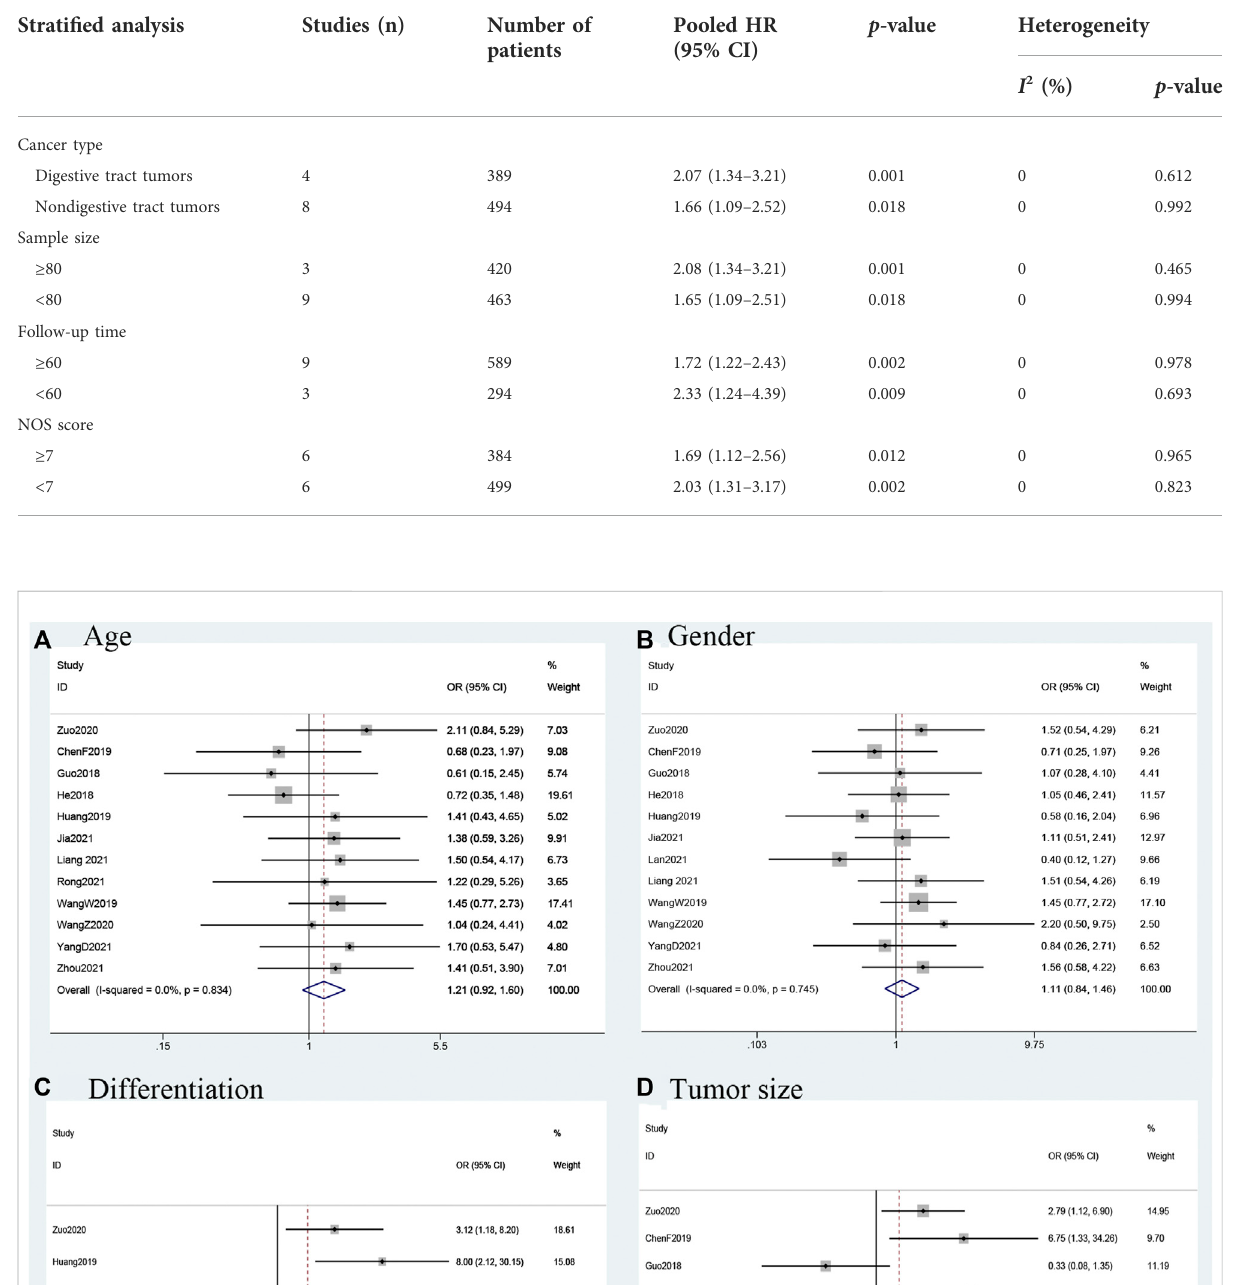
TABLE 2 Subgroup meta-analysis of pooled HRs for